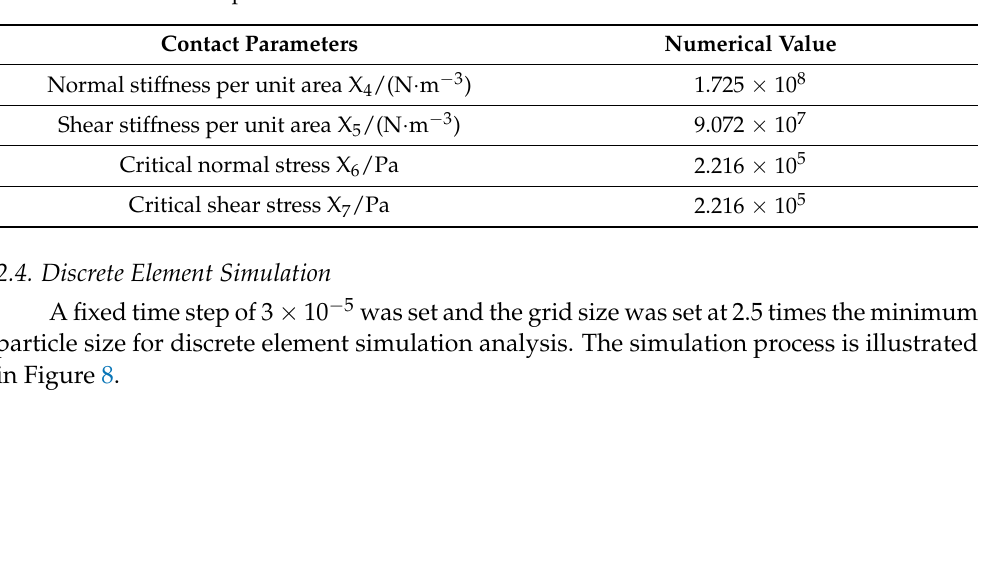
Table 3. Contact model